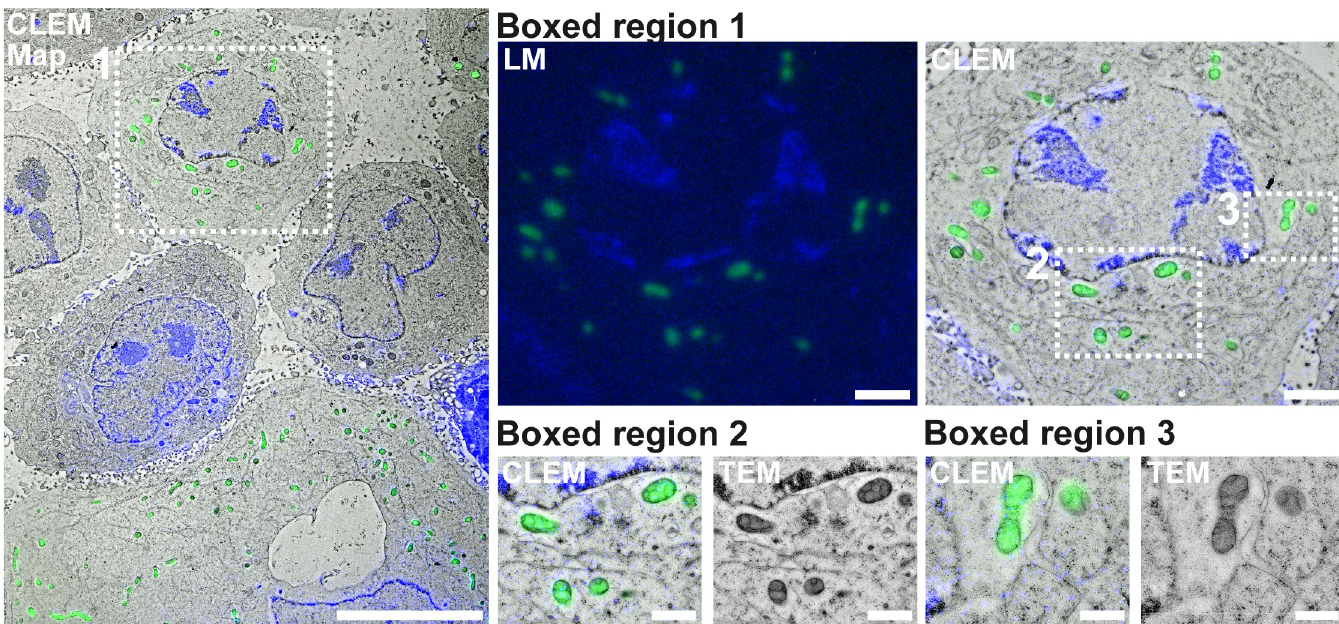
Fig 2. A large-view CLEM image. A large field was imaged in both TEM and fluorescence, relying on the DAPI (blue) channel, which shows the uranyl acetate fluorescence, and on the mito-mCitrine channel (shown here in green). Scale bar: 10 μ m. Boxed region 1 shows a higher zoom view on the light microscopy image as well as the correlated image with TEM of a cell marked by a white square in the overview image. Scale Bar: 2 μ m. Boxed regions 2 and 3 show detailed images of CLEM and TEM in the regions of interest. Scale bar: 1 μ m.